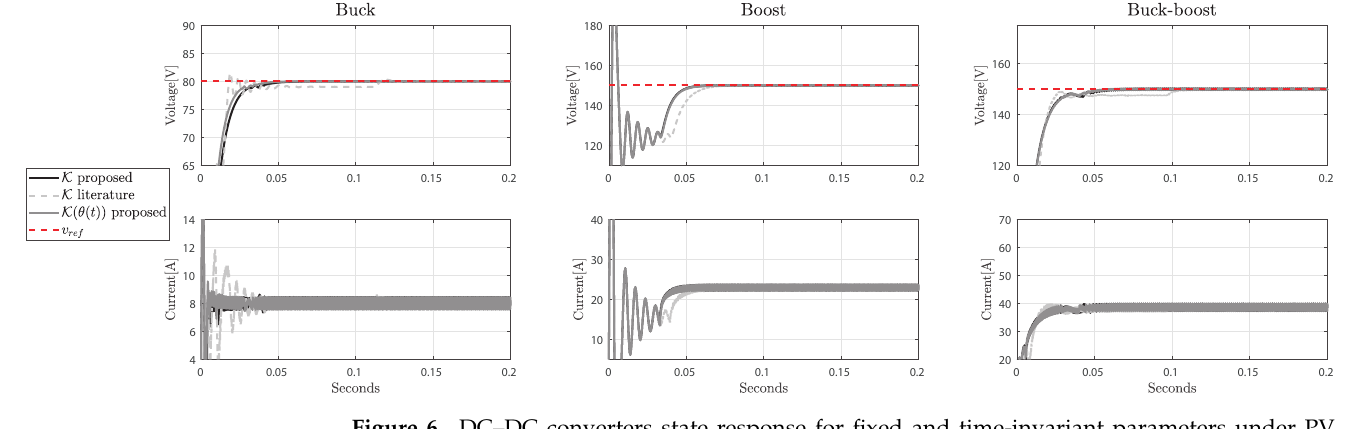
Figure 6. DC–DC converters state response for fixed and time-invariant parameters under PV approach, where nominal values were used for the simulations, i.e., L = 1 mH, C = 680 µF, R = 10 Ω , V in = 100 V and i load = 0.5 A. The upper figures indicate the voltage and the setpoint on the three converters. The lower figures show the current obtained in the inductor.